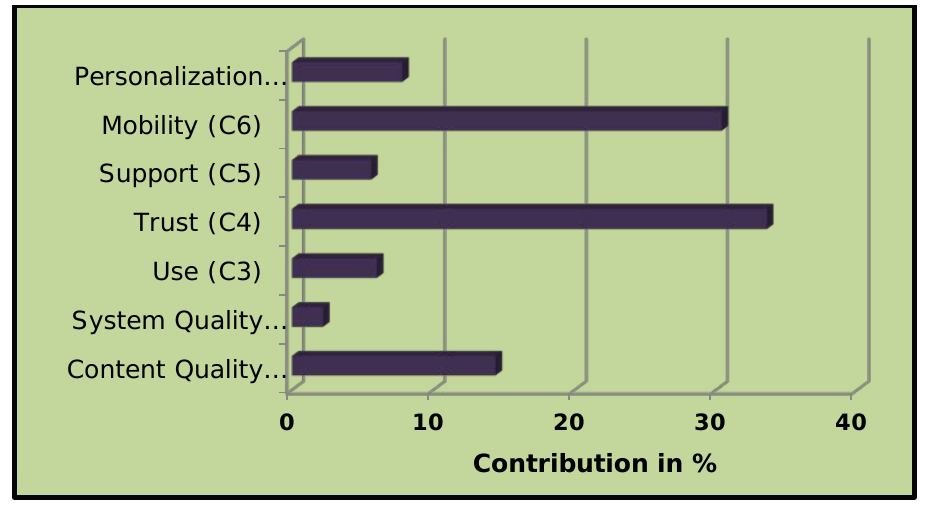
Figure 4. “Contribution of criteria in percentage for the evaluation of m-commerce”.